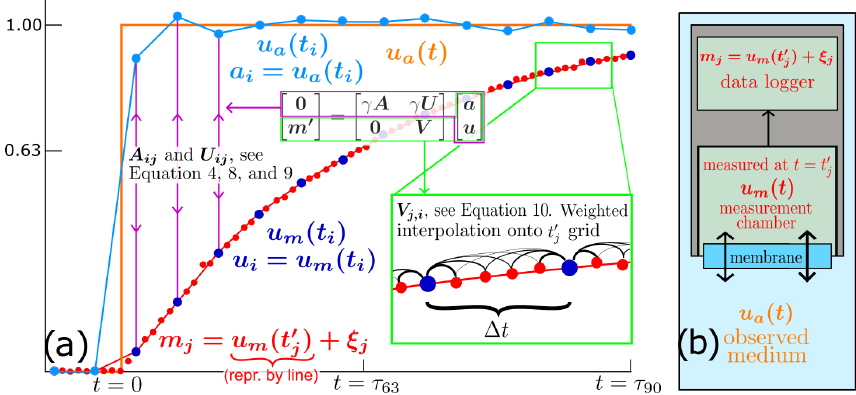
Figure 1. (a) Schematic representation of Eqs. (3)–(10) showing the relationship between the measurements ( m j , red dots), modeled mea- surements (red line), and de-convolution process for a step change in ambient property ( u a orange line) lasting 2 e -foldings ( τ 63 ) of the growth-law equation. Thickness of lines in zoomed inlet indicates weighting during re-sampling onto t j grid. (b) Schematic representation of EB sensor (grey box) during operation and physical location of the different properties in Eqs. (1)–(10). Note that in this schematic ) between the model points u m (t i ) (and not the “true” concentration within the measuring we follow the assumptions of linearity in u m (t (cid:48) j